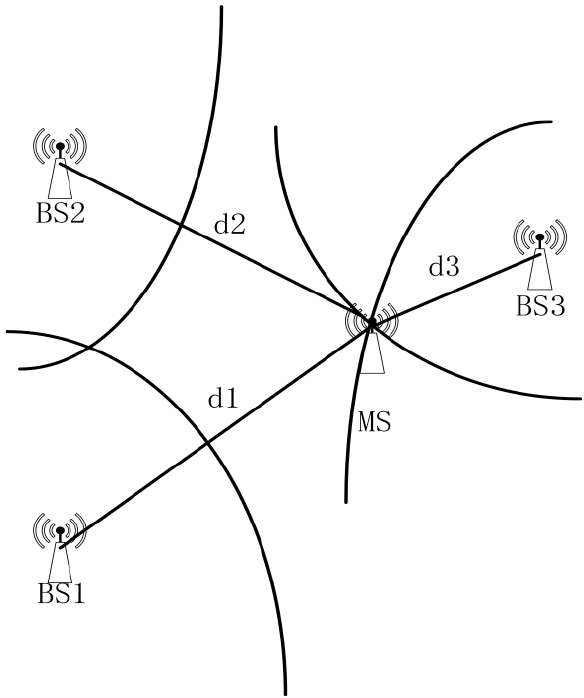
Figure 1. TDOA positioning principle.